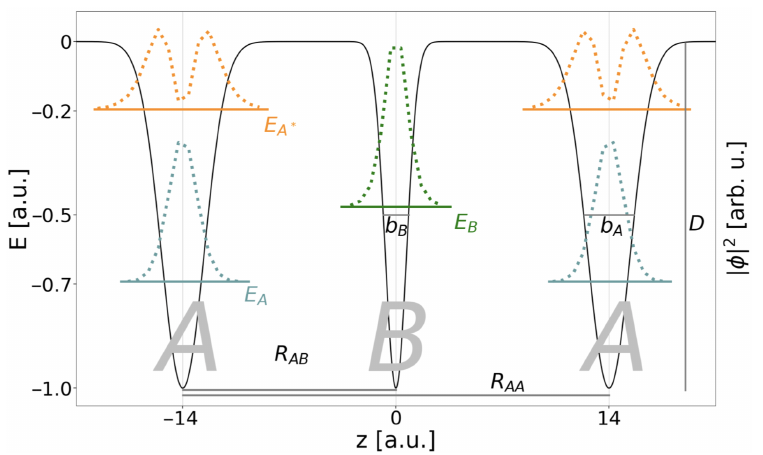
Figure 2. Representation of the three-QD array ABA for a distance R AA = 28a.u. parametrized according to Table 1. In the negative energy range the single-electron levels A (turquoise), B (green), and A ∗ (orange) are displayed together with the respective densities | φ | 2 . Furthermore, the geometric parameters of the binding potential (Equation (9)) are illustrated. Table 1. Energies ina.u. of single- ( E 1 e ) and three-electron states ( E 3 e ), in the latter case for